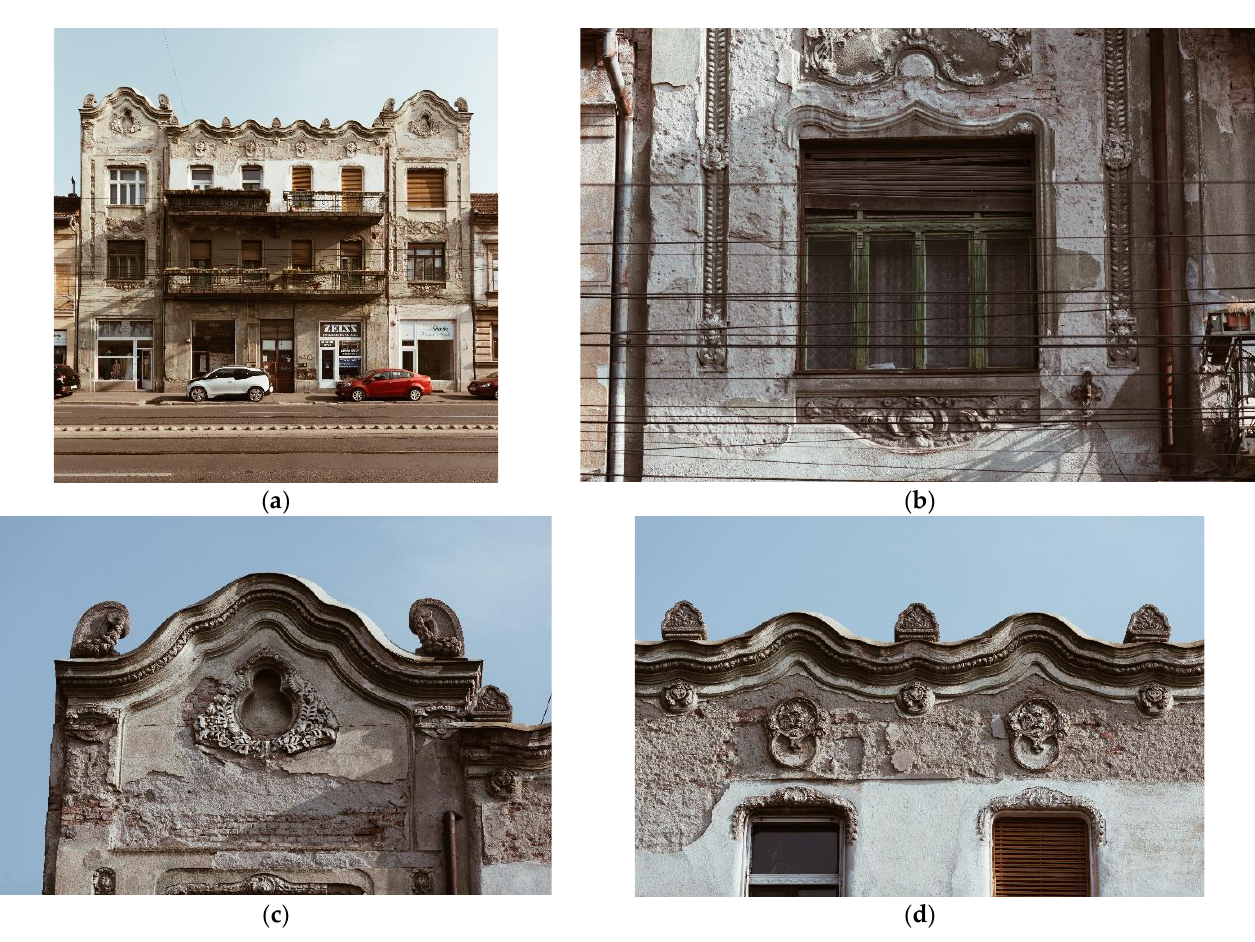
Figure 9. Art Nouveau/Secession motifs — Lajos (Ludwig) Besch and Károly (Karl) Piffl Palace [13] ( a ) General view; ( b ) First floor window; ( c ) Lateral roof detail; ( d ) Central roof detail.